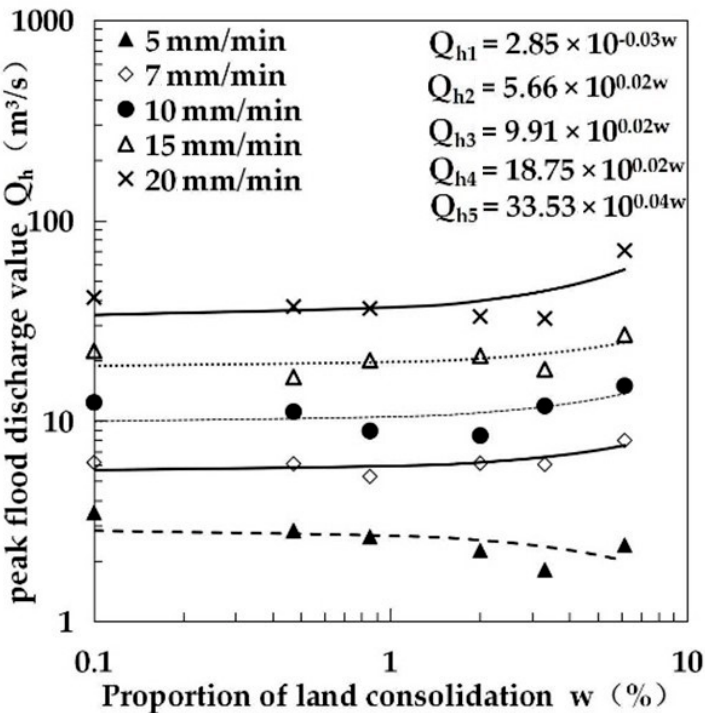
Figure 22. Changes in peak flood discharge value with land consolidation proportion under different rainfall intensities.